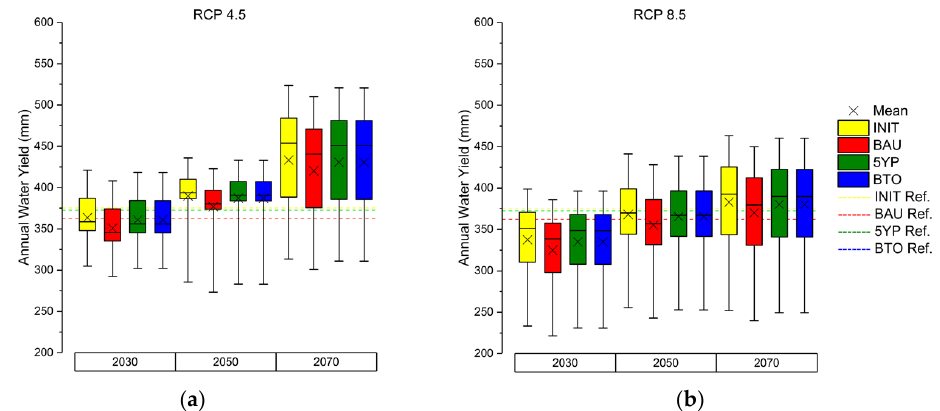
Figure 4. Annual average water yield in Nabanhe Reserve calculated with InVEST using ensemble data (9 GCMs) of two Relative Concentration Pathways (RCP 4.5 ( a ) and RCP 8.5 ( b ) of the Fifth Assessment Report of the IPCC) for the time slices of 2030 (20-year average from 2020–2040), 2050 (20-year average from 2040–2060) and 2070 (20-year average from 2060–2080). Boxes and whiskers show the 25/75 and 10/90 percentiles respectively. Lines in boxes show the ensemble median, whereas crosses show the ensemble mean. Colors represent land use conditions: Initial case of 2015 (INIT, yellow), Business-As-Usual scenario (BAU, red), 5-years-plan scenario (5YP, green), Balanced-Trade-Offs scenario (BTO, blue). The dotted lines show annual average water yield calculated with long term annual average climate data as a baseline (WorldClim v1.4. [39,40]).